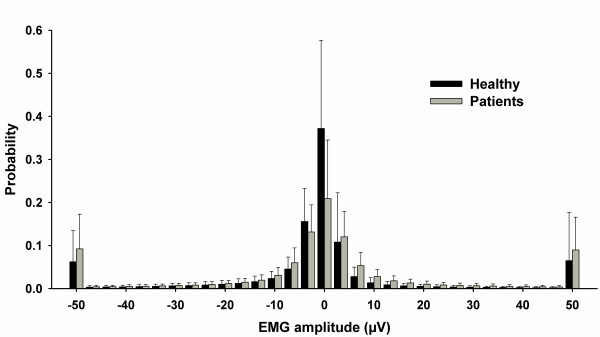
Average histogram of EMG signals from all patients and healthy subjects. Error bars represent standard deviation.